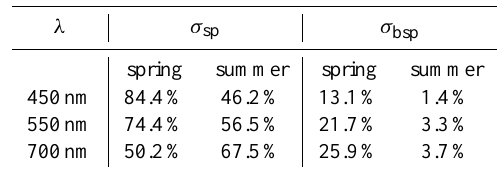
Table 3. The ratios of the amount of nephelometer-measured σ sp and σ bsp that fall within the range of the corresponding calculated values based on the assumptions of internal and external mixture to the total amount of the measured values.